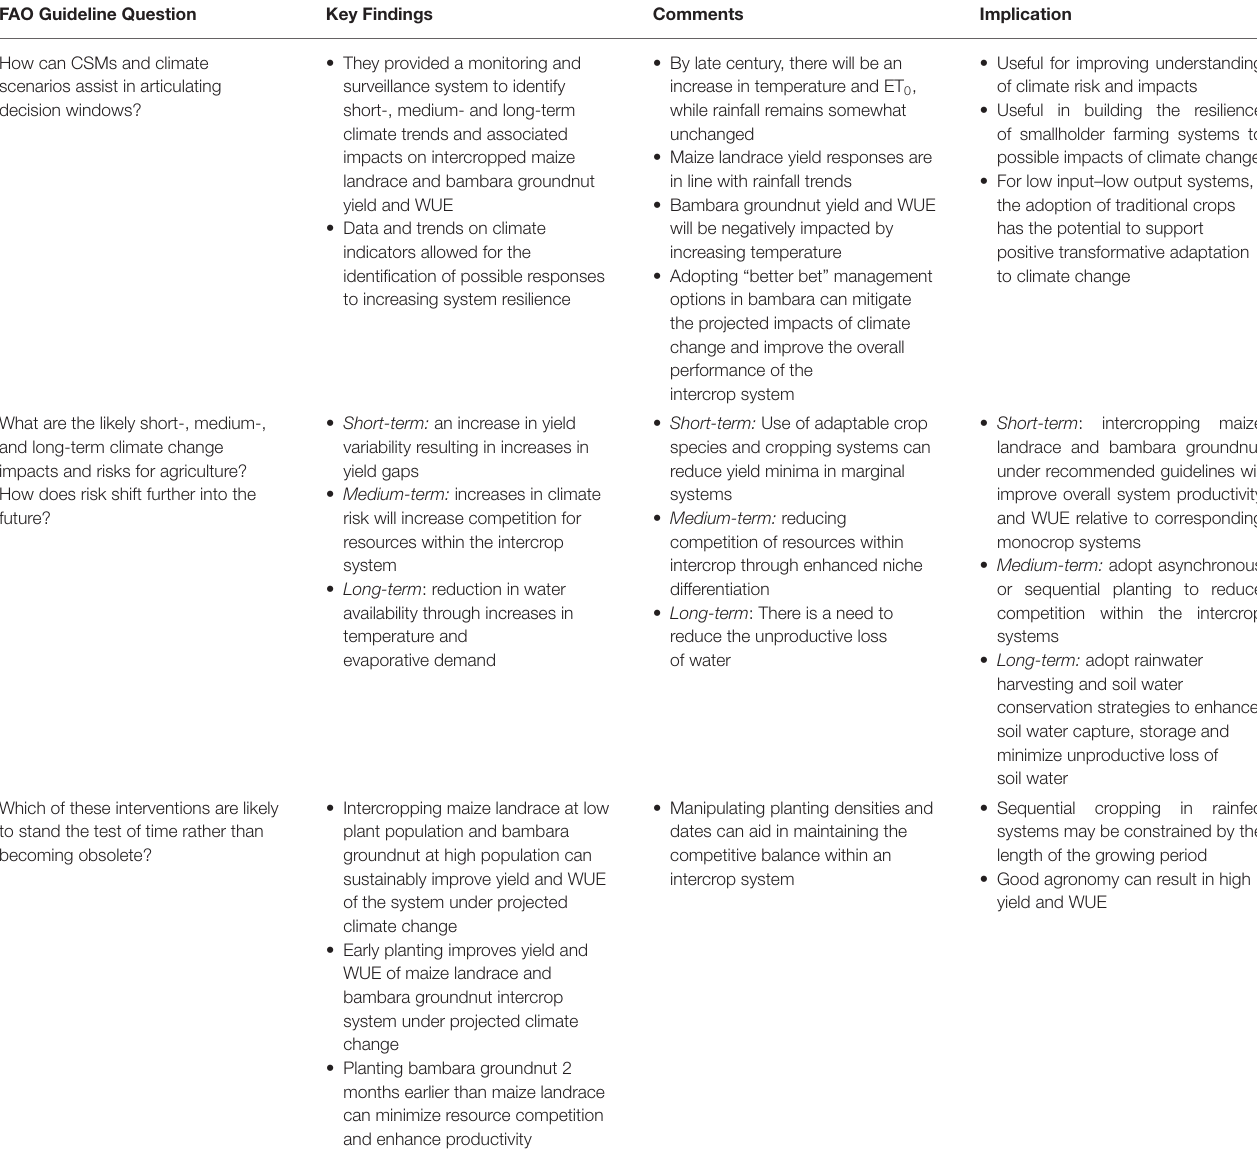
TABLE 5 | FAO guidelines and key questions for assessing the impacts of adaptation strategy. FAO Guideline